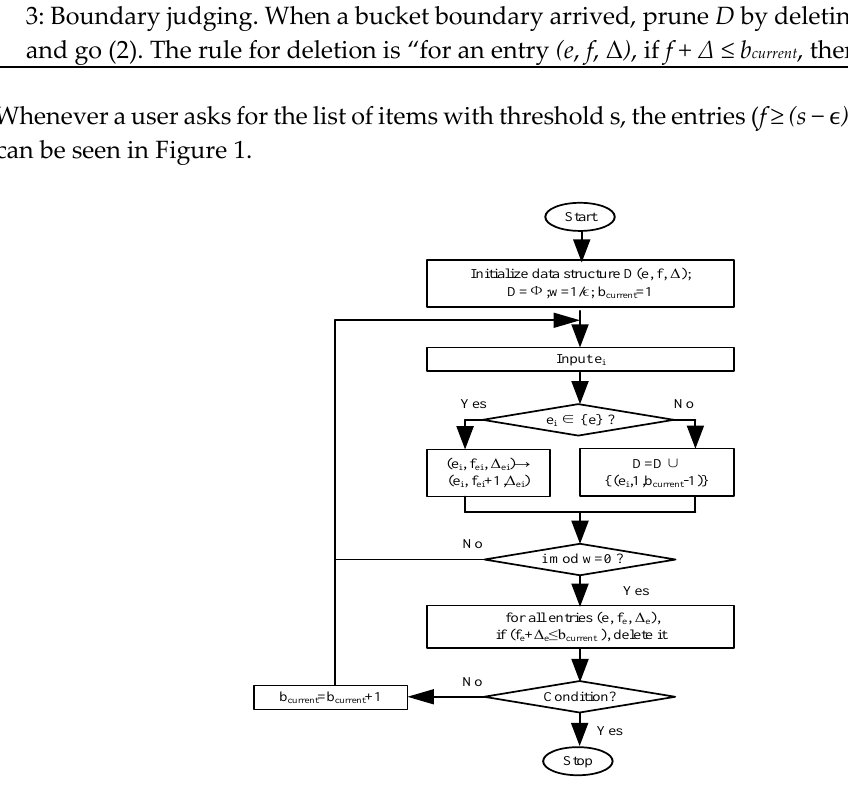
Figure 1. The flow chart of the lossy counting